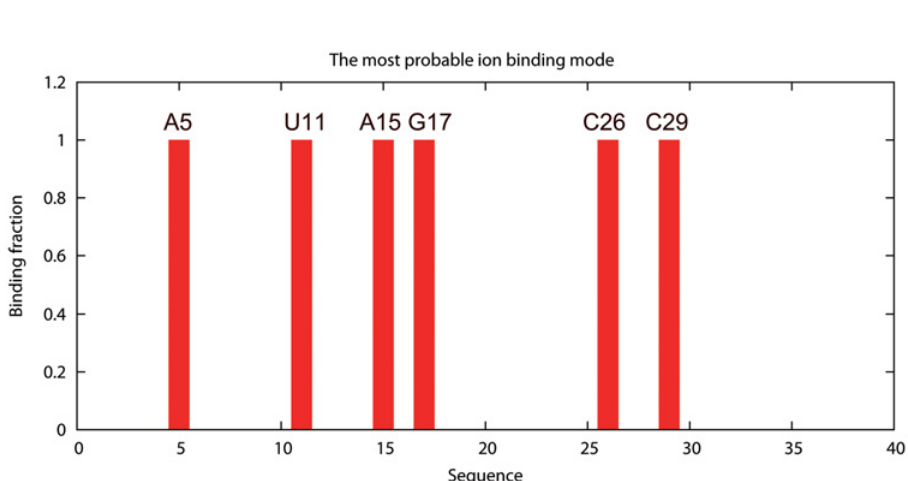
Fig 3. The average binding fraction. The average binding fraction on each nucleotide of the T2 RNA pseudoknot in 10mM Mg 2+ and 100 mM Na + at T = 37°C.